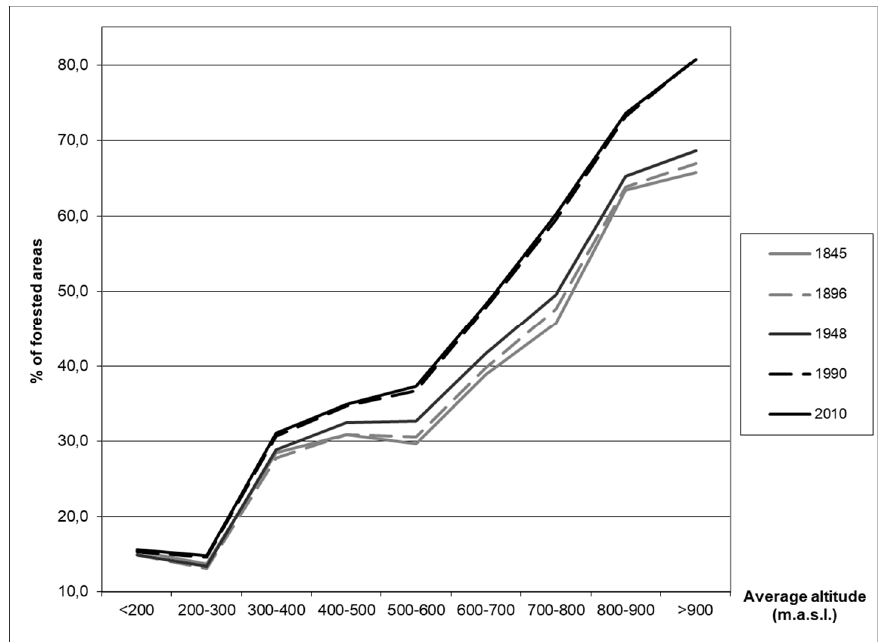
Figure 6. Changing share of forested areas (%) according to average altitude of BTUs. Source: own calculation, LUCC Czechia database.